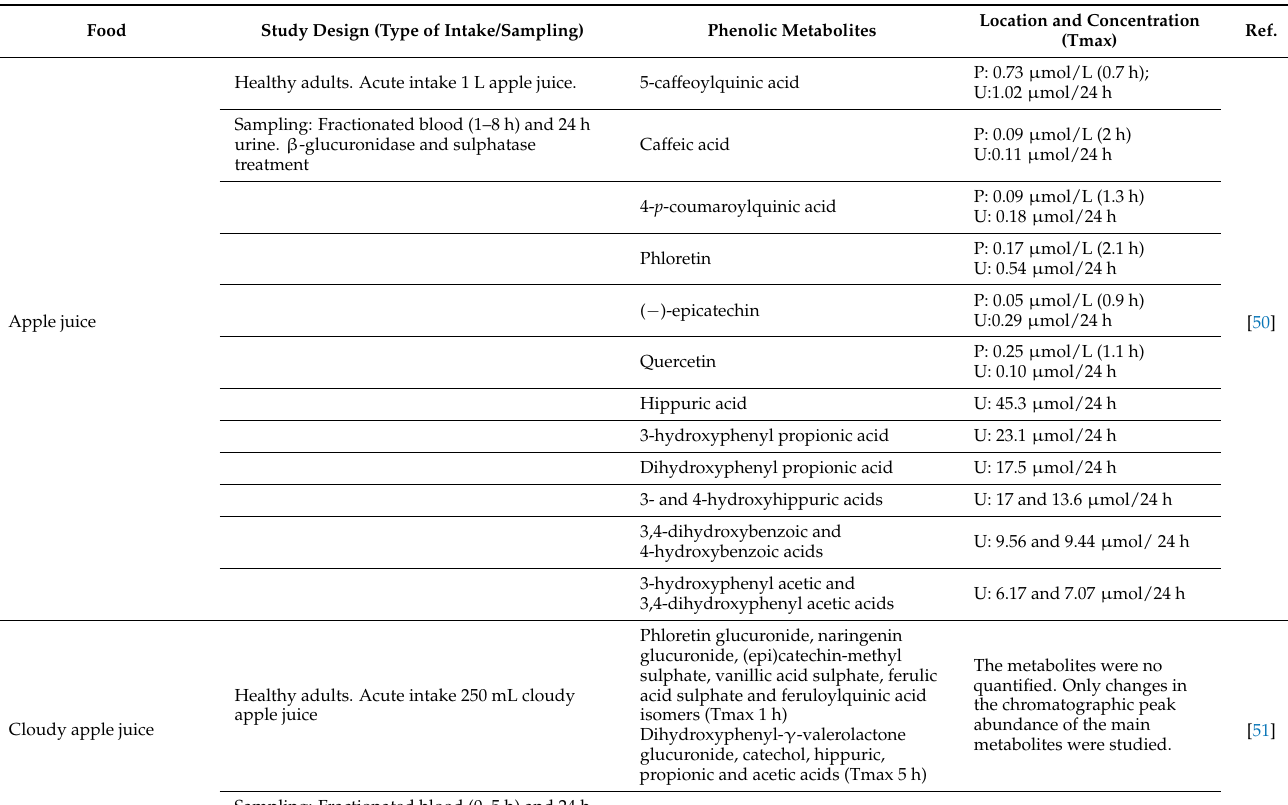
Table 4. Phenolic metabolites (phase I, phase II) proposed as intake biomarkers of the most representative ingested fruits in the Mediterranean